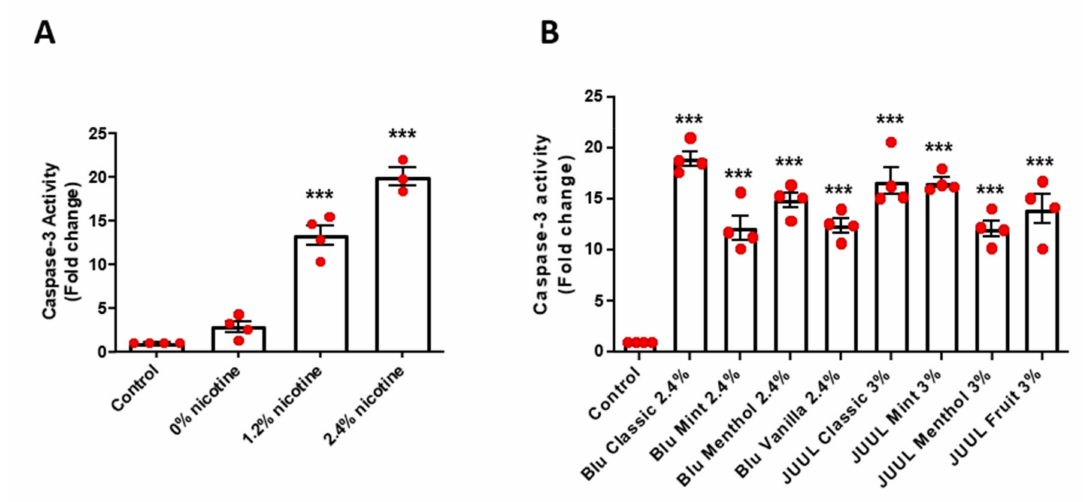
Figure 3. Nicotine-containing and flavored e-cigarettes increase endothelial cell apoptosis. Confluent bovine aortic endothelial cells (BAECs) were starved overnight and incubated with e-cigarette smoke extract (e-CSE) for 24 h. e-CSEs were prepared from e-cigarettes Gold leaf (Blu) at nicotine levels of 0%, 1.2%, and 2.4%, and flavored e-cigarettes (Blu: Classic, Mint, Menthol, and Vanilla, all with 2.4% nicotine levels; and JUUL: Classic, Mint, Menthol, and Fruit, all with 3% nicotine levels). Endothelial cell apoptosis was assessed using an apoptosis assay kit (CASP3F, MilliporeSigma). ( A ) Grouped data of endothelial apoptotic activity from endothelial cells treated with e-CSEs prepared from e-cigarettes containing 0, 1.2%, and 2.4% nicotine levels. ( n = 4). ( B ) Grouped data of endothelial apoptotic activity from endothelial cells treated with e-CSEs prepared from flavored e-cigarettes (Blu: Classic, Mint, Menthol, and Vanilla, all with 2.4% nicotine levels; and JUUL: Classic, Mint, Menthol, and Fruit, all with 3% nicotine levels). ( n = 4). *** p < 0.001 vs. Control group by One-Way ANOVA